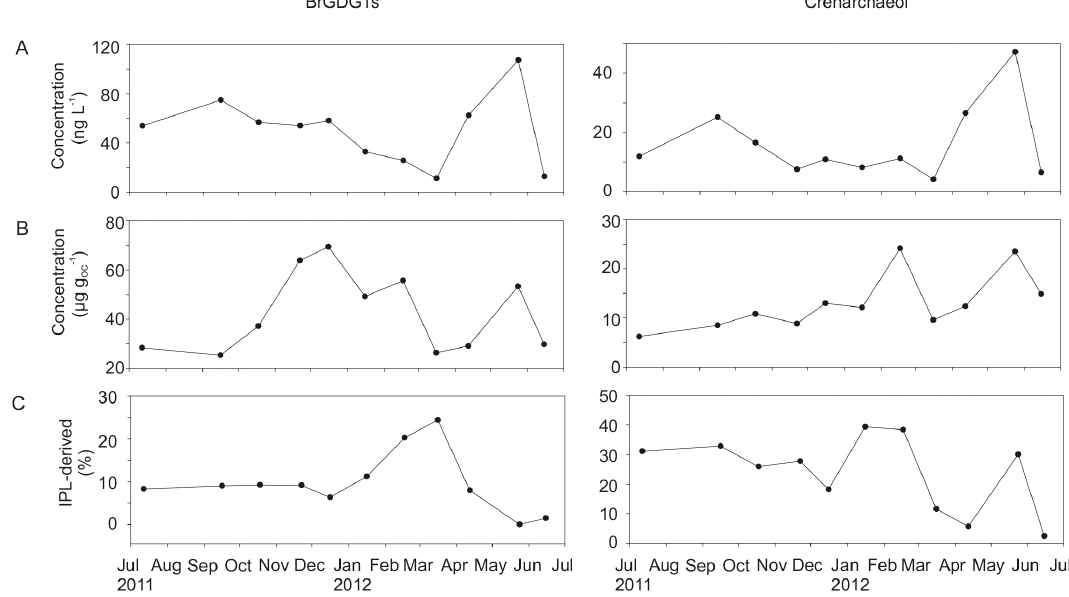
Figure 6. Variations in CL brGDGT and CL crenarchaeol concentrations and the percentage of IPL-derived brGDGTs and crenarchaeol in Tagus SPM over a year (2011–2012).